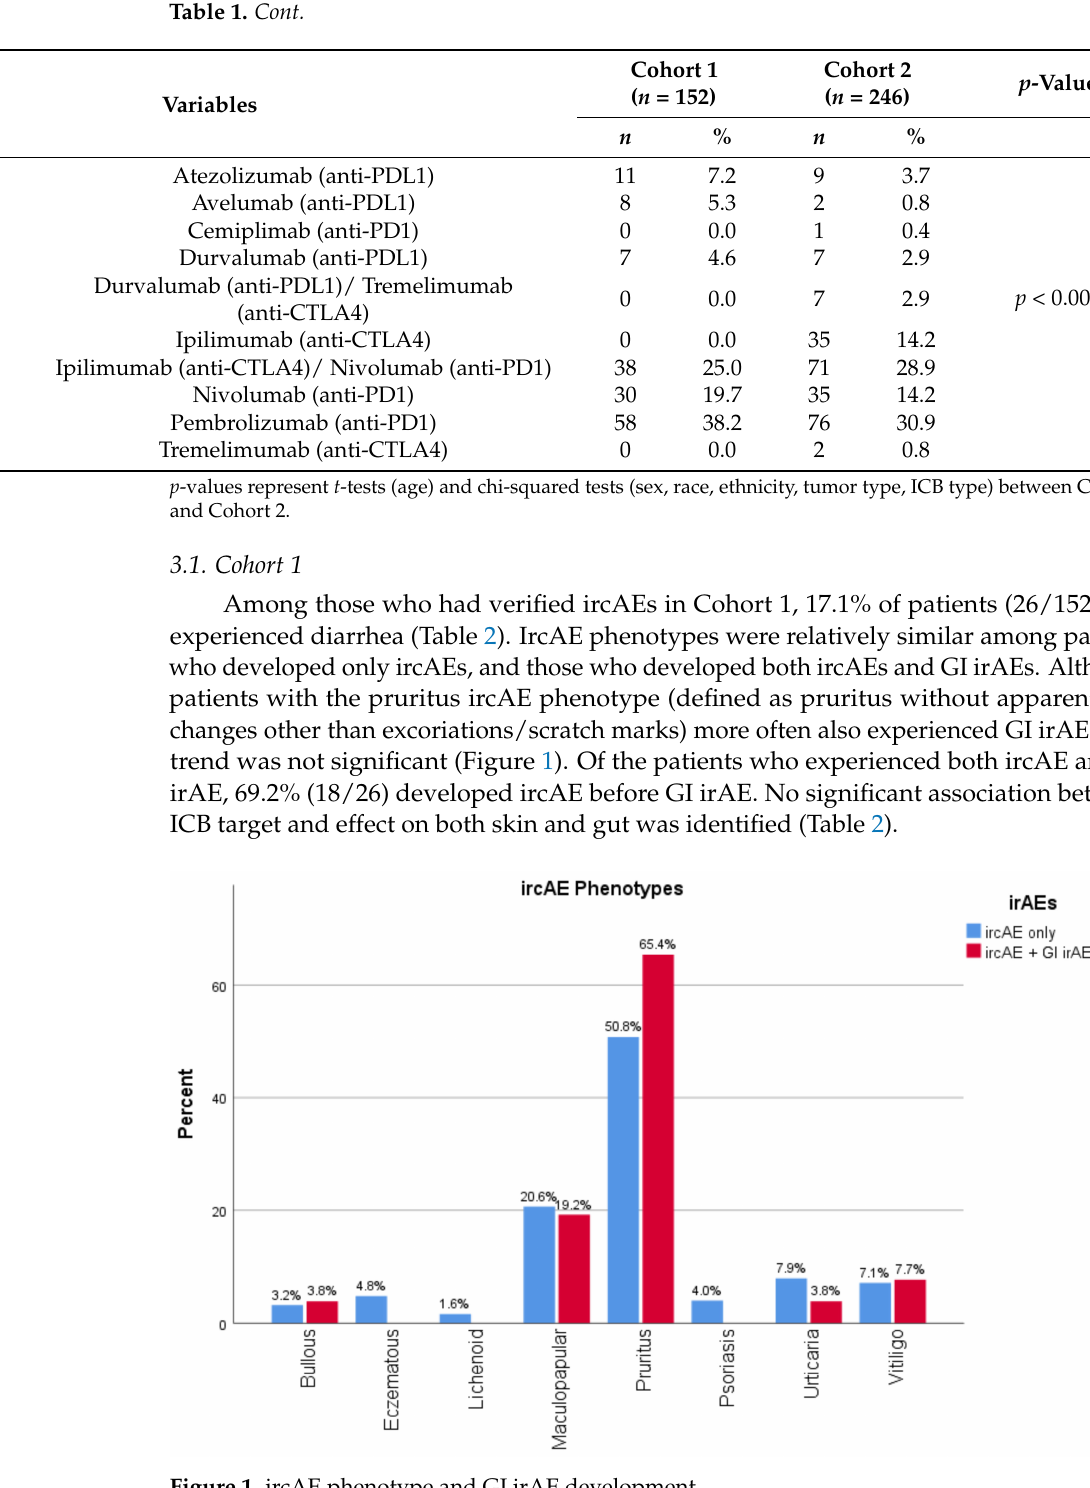
Figure 1. ircAE phenotype and GI irAE